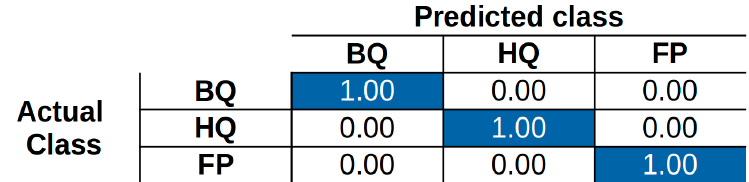
Figure 11. Confusion matrix evaluated on the test set.